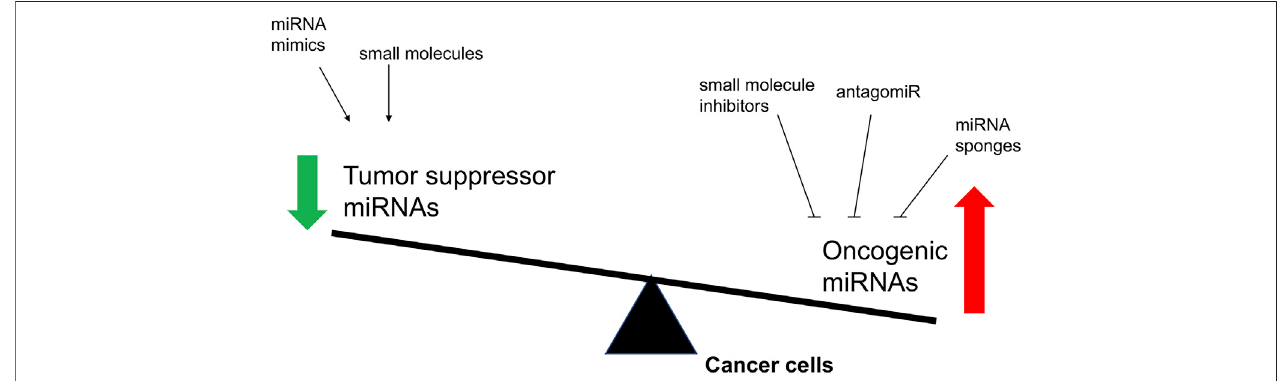
FIGURE3| TheoverviewofproposedstrategiestoregulatethebiologicalactivityofmiRNAsinvolvedincancer.Theobjectivesofthesemolecularinterventionsare the downregulation of oncomiRNAs or the restoring of tumor suppressor miRNAs.